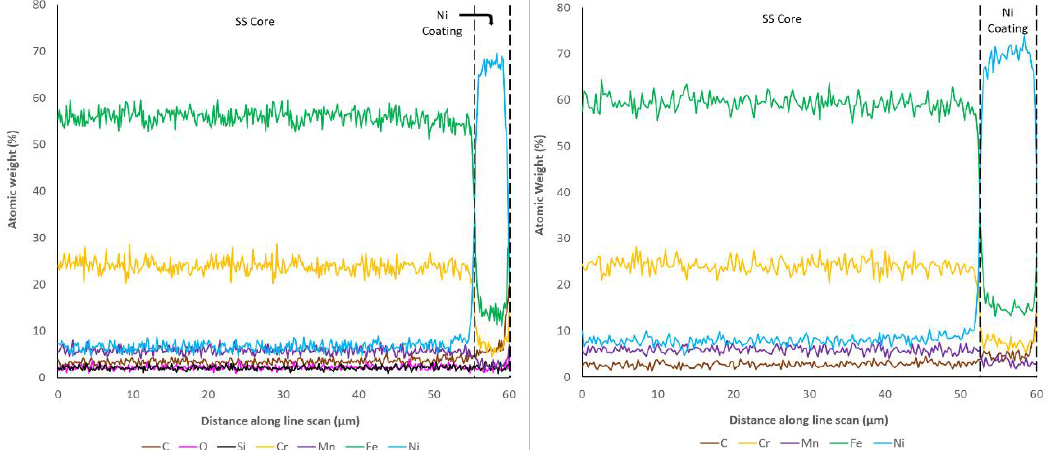
Figure 18. Element atomic weight distribution for the SS Ni thin-walled pipe ( left , 6) and thick-walled pipe ( right , 7) at the core-coating boundary.